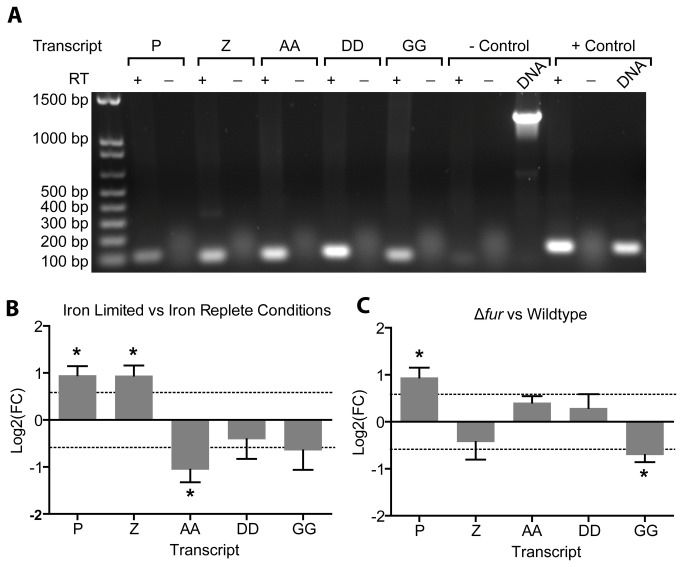
Regions containing identified novel transcripts are transcriptionally active and iron responsive in C. jejuni.
RT-PCR was used to confirm the transcriptional activity of putative ncRNAs (Panel A). Templates marked + and - represent PCR reactions with and without reverse transcriptase respectively. RT-qPCR was used to determine if validated transcripts were responsive to iron (Panel B) or Fur regulation (Panel C) with a p value <0.05 (*).